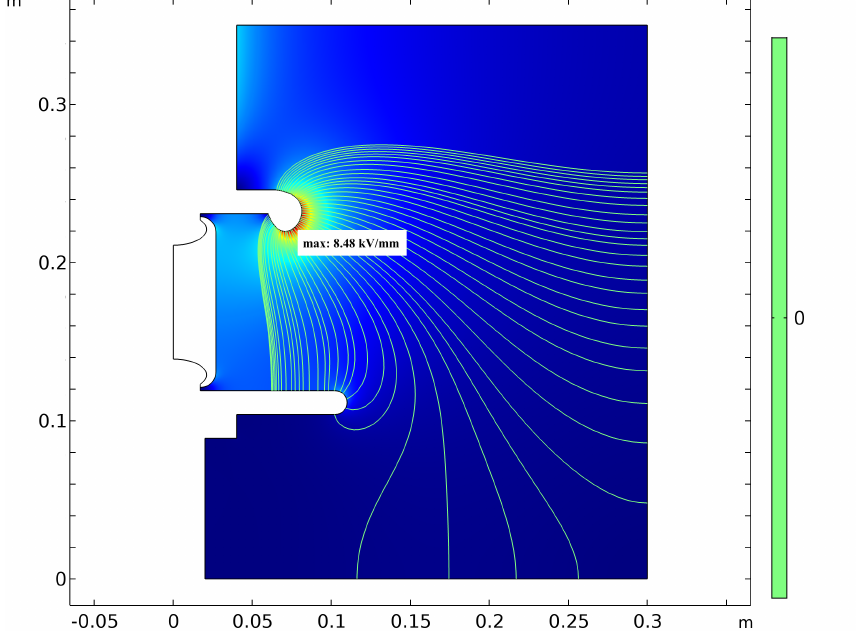
Figure 10. Streamer integrals (15) and electric field map for for the optimized electrode shape. The peak value of the electric field is reduced to about 8.5 kV/mm and the streamer criterion is not exceeded for any of the calculated trajectories for which the integral (15) is always